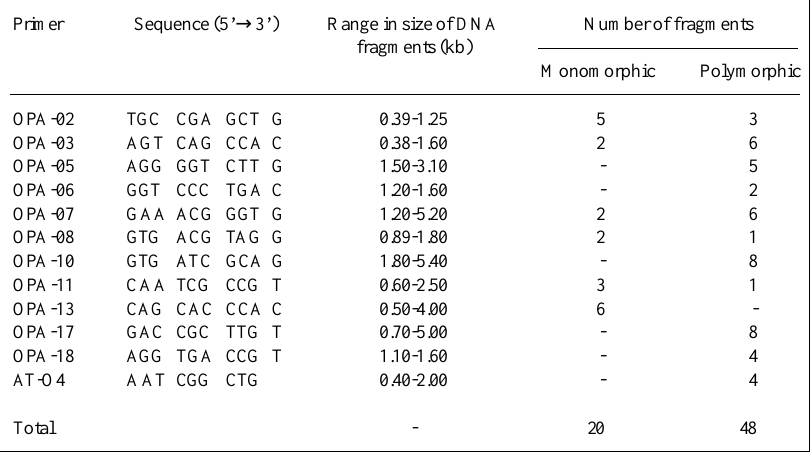
Table II - List of primers used in this study, range in size of DNA fragments (kb), and number of monomorphic and polymorphic